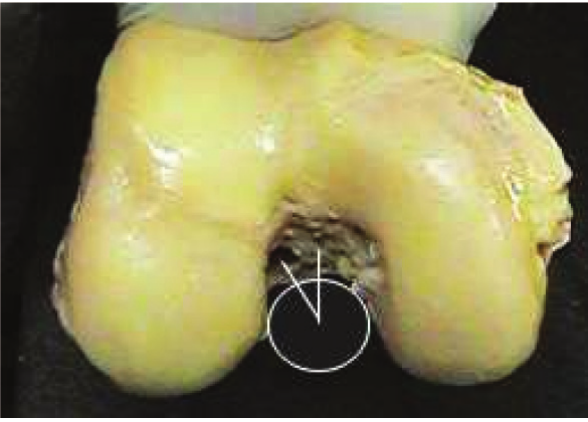
Figure 1 – Thickness of the posterior cortex